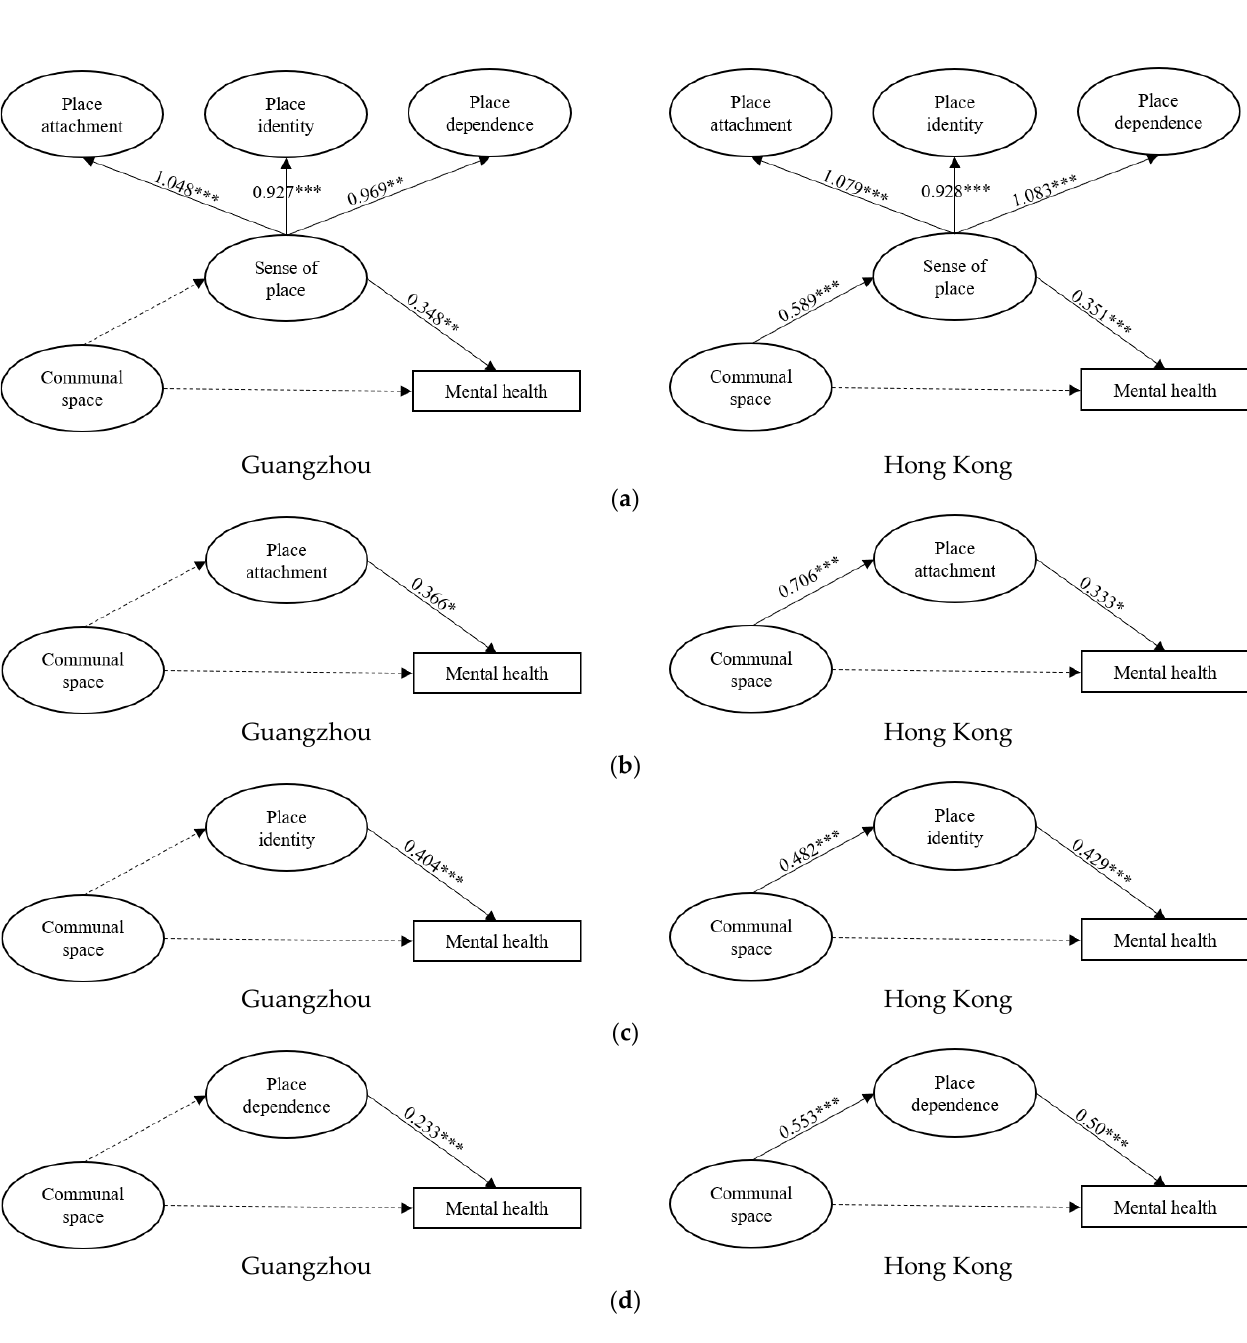
Figure 3. Pathways of model 1 – 4. ( a ) Model 1: Pathways of communal space linking sense of place and mental health in younger residents; ( b ) Model 2: Pathways of communal space linking place attachment and mental health in younger residents. ( c ) Model 3: Pathways of communal space linking place identity and mental health in younger residents; ( d ) Model 4: Pathways of communal space linking place dependence and mental health in younger residents. Note. *** p < 0.001, ** p < 0.01, * p < 0.05; the solid line is the significant path, but the dotted line is not.